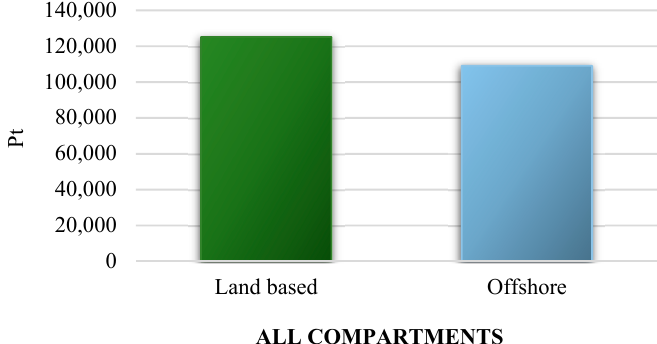
Figure 11. Results of grouping and weighing environmental effects occurring in life cycles of land-based and offshore wind power plants. Authors’ own research.